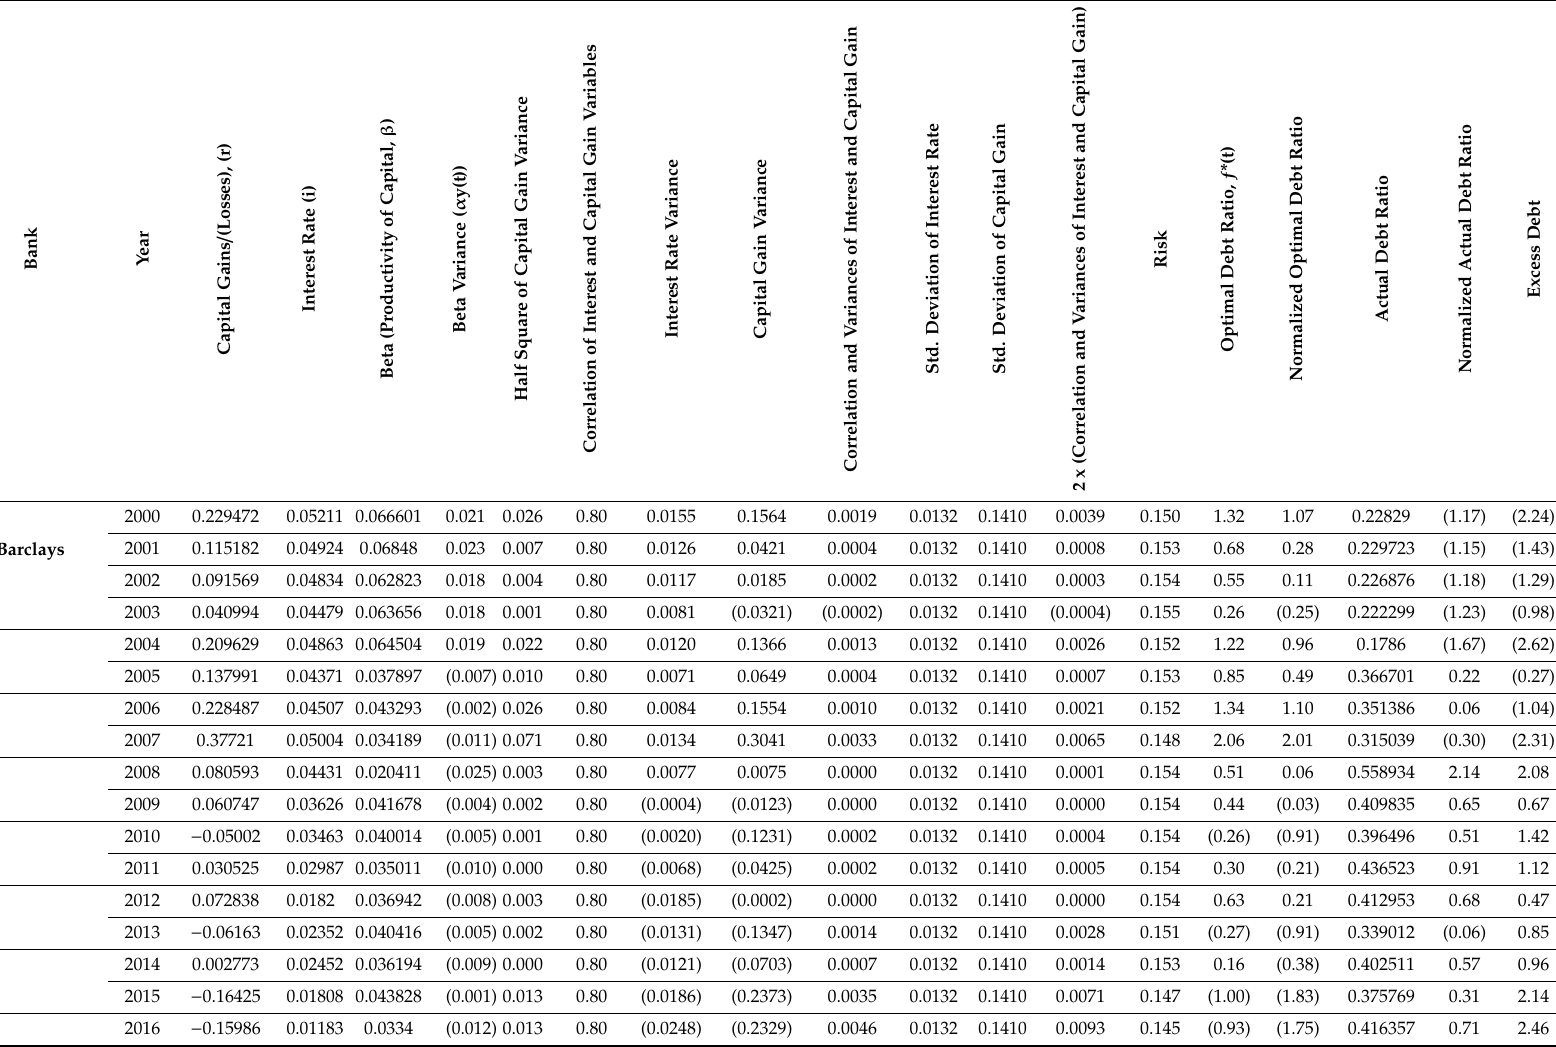
Table A18. Calculations of Optimal and Excess Debt: